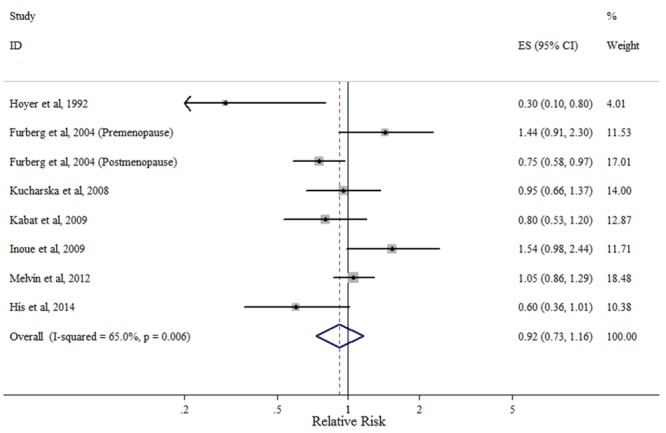
Forest plot of the highest vs. lowest categories of serum HDL-C levels and breast cancer risk.Squares indicate study-specific relative risk estimates (size of the square reflects the study-specific statistical weight); horizontal lines indicate 95% confidence intervals (CI); diamond indicates the overall relative risk with its 95% confidence interval.